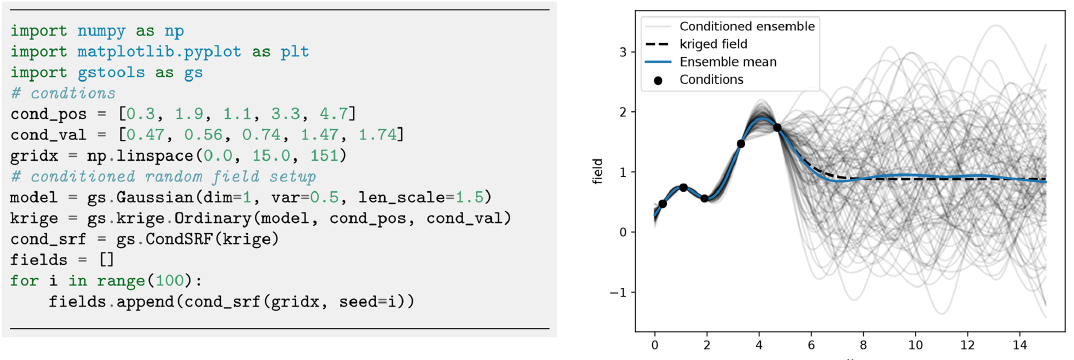
Figure 12. An example for an ensemble of 1D random fields conditioned to five measurements (dots). Plotting commands have been omitted.